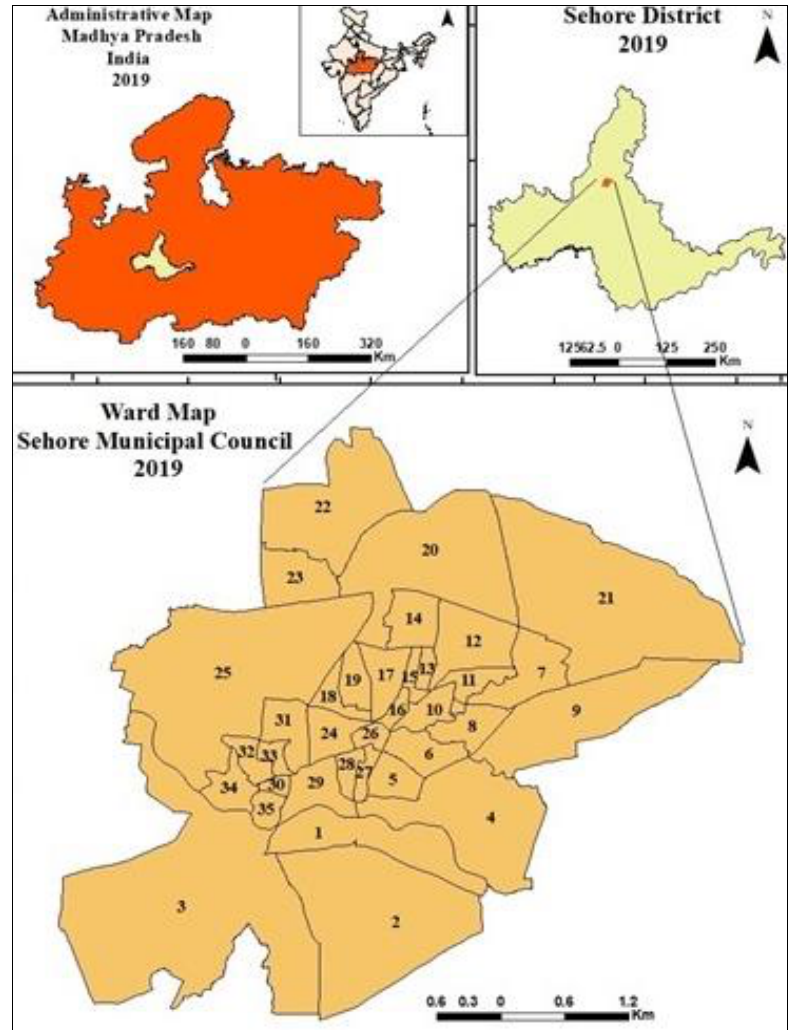
Fig. 1. Administrative Map of Sehore Municipal Council, Madhya Pradesh, India